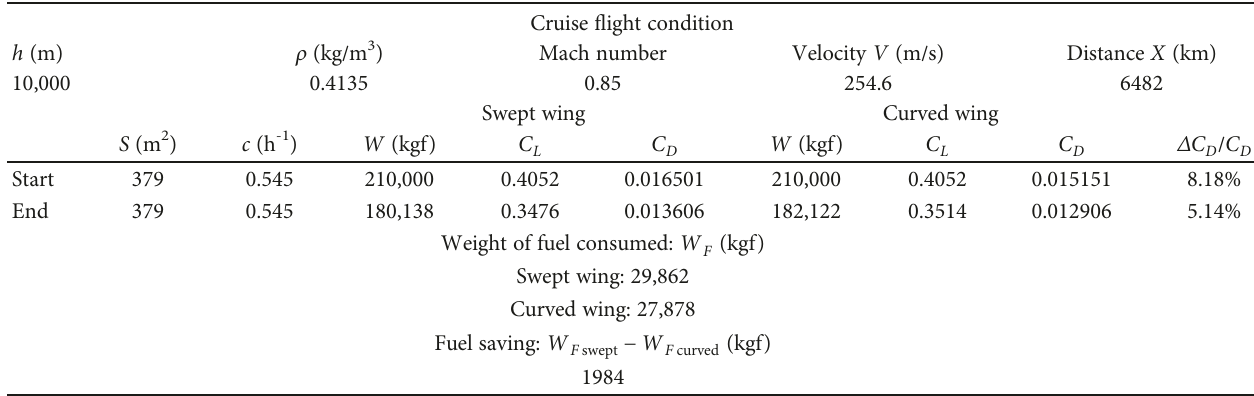
Table 3: Estimation of fuel saving for a long-range